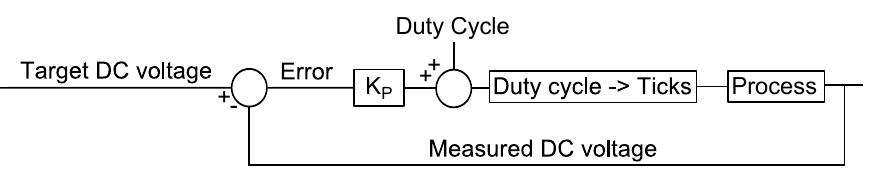
Figure 6. P-controller loop of the DC bus